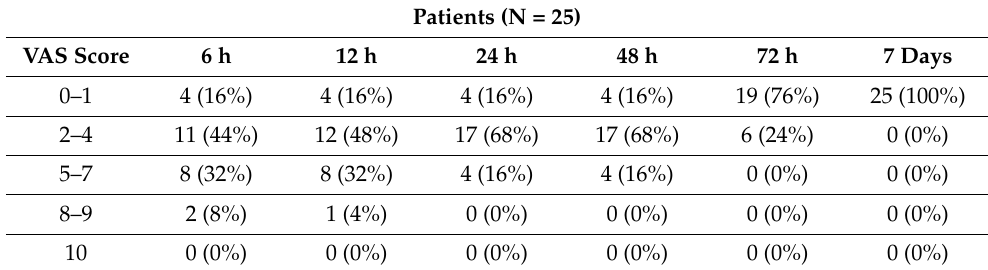
Table 4. VAS Scores.